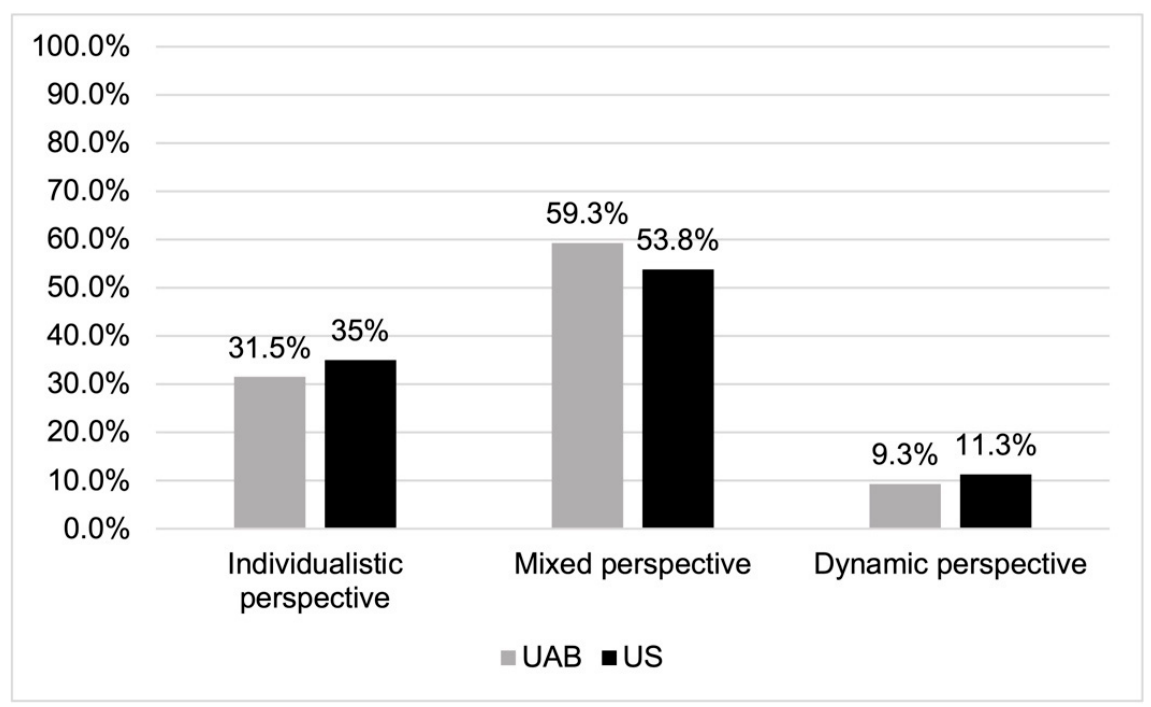
Figure 1. Percentages of the comparison between typologies on the construction of their identities.